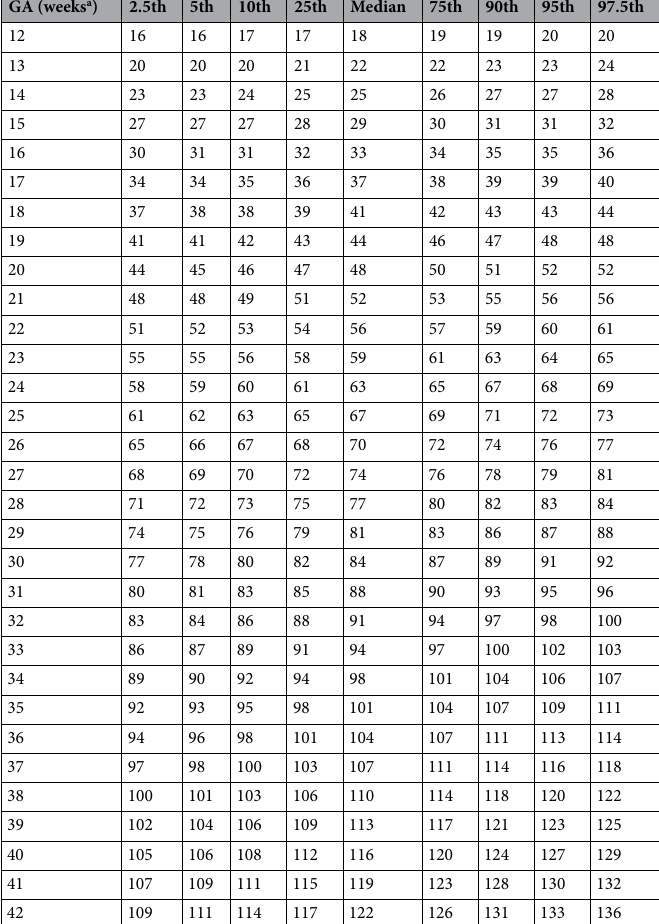
Table 7. Estimated mean abdominal diameter (MAD) in mm by gestational age (GA) for males and females, percentiles. a GA expressed as completed gestational weeks, e.g. 12 weeks corresponds to 12 + 0 weeks or 84 gestational